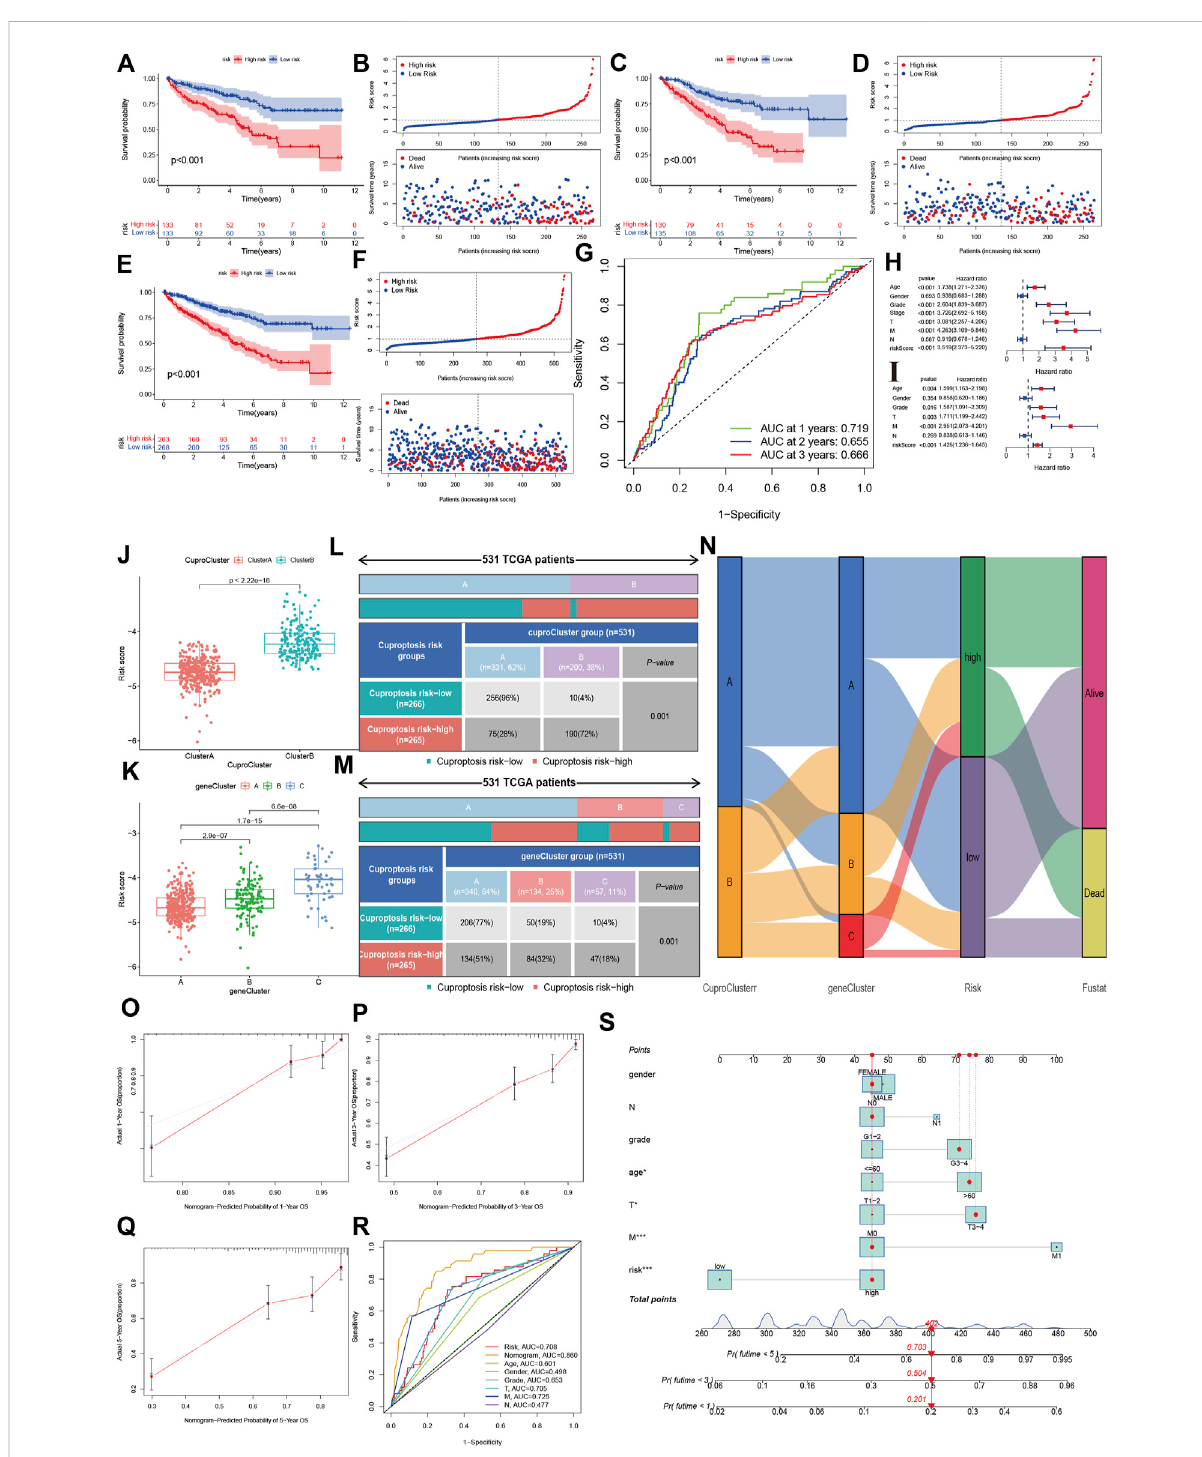
Development and validation of the cuproptosis-related prognostic model. (A,B) : The Kaplan-Meier (K – M) survival curve and risk distribution of thepatients inthe training group. (C,D) : The K-M survival curveand the risk distribution of thepatients in the validation group. (E,F) : The K-M survival curveandriskdistribution ofpatients inthewholedataset. (G) :Thetime-independentROC of1-year,2-year,and3-yearoverallsurvival. (H,I) :Forest plot of univariate and multivariate Cox regression for the risk score. (J,K) : Risk scores for cuproptosis clusters and gene clusters. (L – N) : Correlations of risk groups with cuproptosis clusters, gene clusters, and clinical outcomes. (O) : Nomogram that predicts individual risk based on risk groups and clinical parameters. (P – S) : The calibration plot of the observed value and the probability predicted by the nomogram at 1 year, 3 years, and 5 years. (R) : AUCs of the risk score and clinical